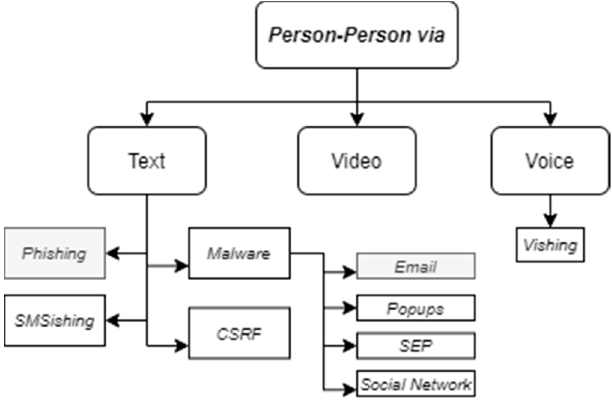
Figure 1. Social engineering attack taxonomy. Reproduced from Figure 2 in [17].